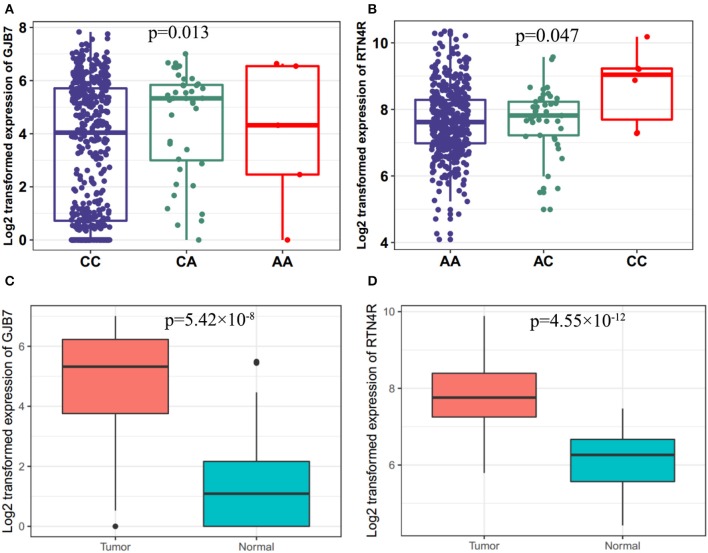
Associations between the risk genotypes and their corresponding mRNA expression levels. (A) The eQTL for gene GJB7 and rs16879870 (P = 0.013) (B) eQTL for gene RTN4R and rs854936 (P = 0.047) in cancer tissues of TCGA in the additive model. eQTL, expression quantitative trait loci analysis. Differential expression analysis for (C)
GJB7 (P = 5.42 × 10–8) and (D)
RTN4R (P = 4.55 × 10–12) in the TCGA dataset.